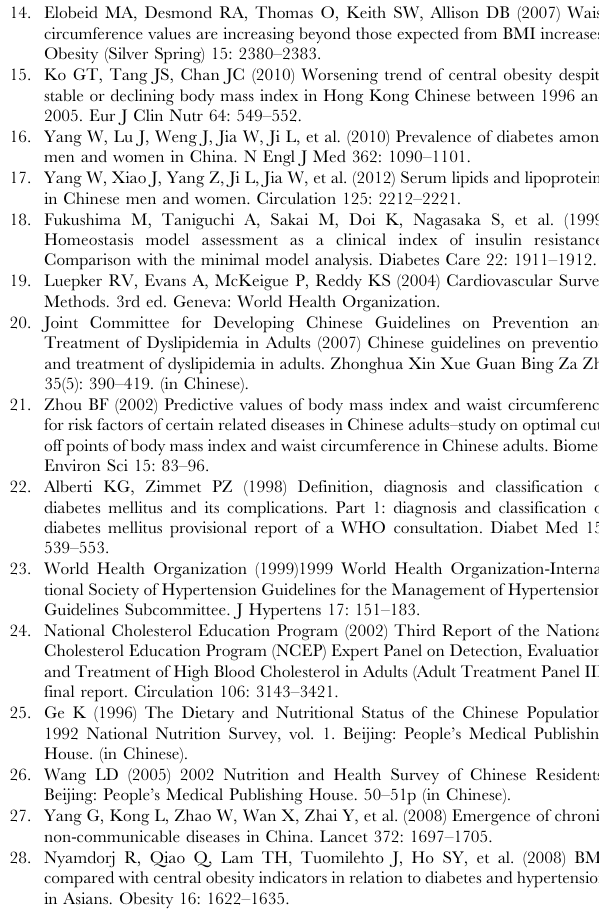
Figure S1 Receive operating characteristic curve of combined WC and BMI categories in identifying indi- viduals with CMD or CVD. Receive operating characteristic (ROC) curve analyses were conducted to determine the optimal cutoffs of combined WC and BMI categories in identifying individuals with DM, hypertension, dyslipidemia (in Figure S1A), CHD, stroke, or CVD (in Figure S1B). Area under curve (AUC) and their corresponding 95% confidence interval (CI) were presented. Table S1 Standardized Mean of BMI and Waist Cir- cumference by Gender and Age Group.